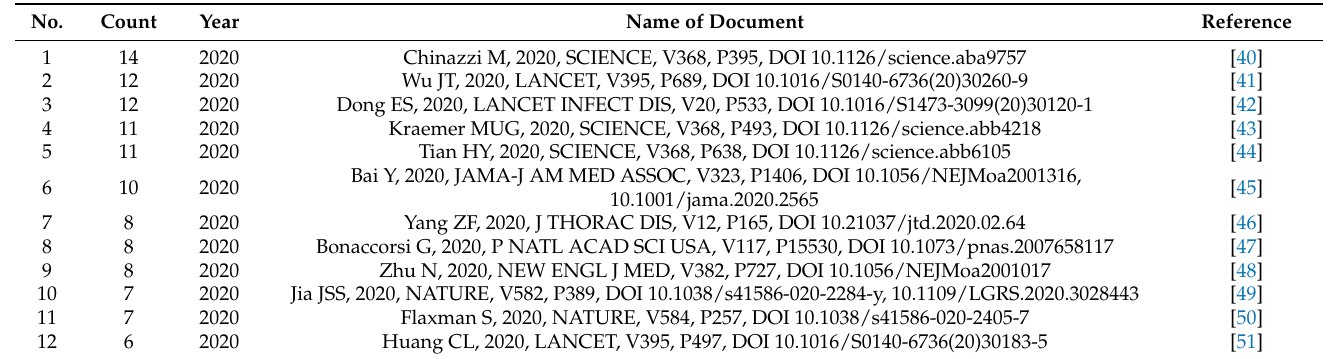
Table 7. Top 12 most cited documents of studies of epidemic control based on big data research, extracted through CS